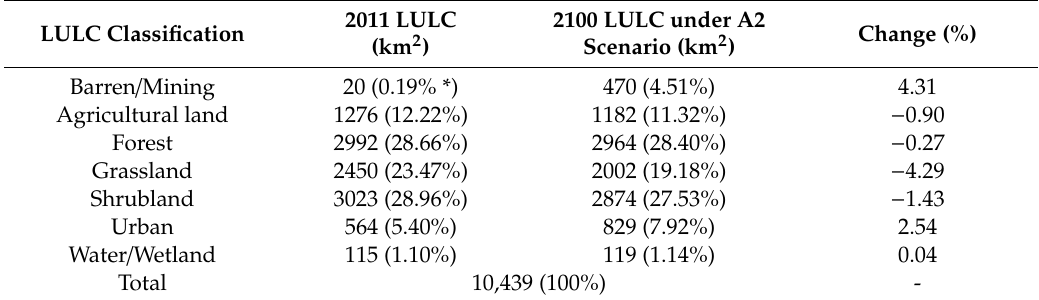
Table 2. LULC classification and variation from 2011 to 2100 LULC associated with the A2 scenario. 2011 LULC 2100 LULC under A2 Change (%) LULC Classification (km 2 ) Scenario (km 2 ) Barren / Mining 20 (0.19% *) 470 (4.51%) 4.31 Agricultural land 1276 (12.22%) 1182 (11.32%) − 0.90 Forest 2992 (28.66%) 2964 (28.40%) − 0.27 Grassland 2450 (23.47%) 2002 (19.18%) − 4.29 Shrubland 3023 (28.96%) 2874 (27.53%) − 1.43 Urban 564 (5.40%) 829 (7.92%) 2.54 Water / Wetland 115 (1.10%) 119 (1.14%) 0.04 Total 10,439 (100%)